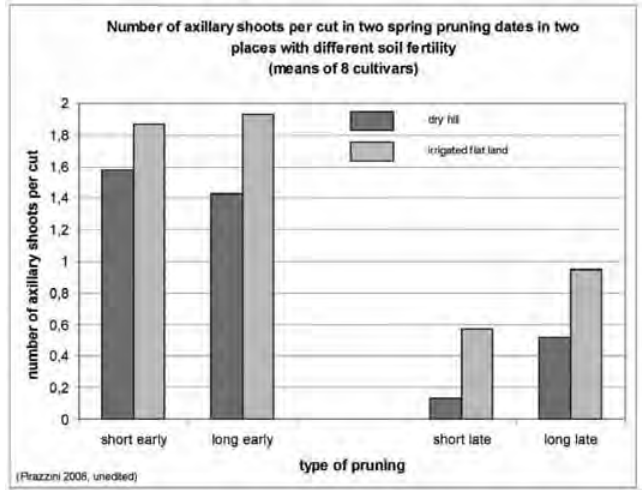
Fig. 3 - Number of sylleptic shoots per single cut in response to short and long pruning delaying the operations from early to late